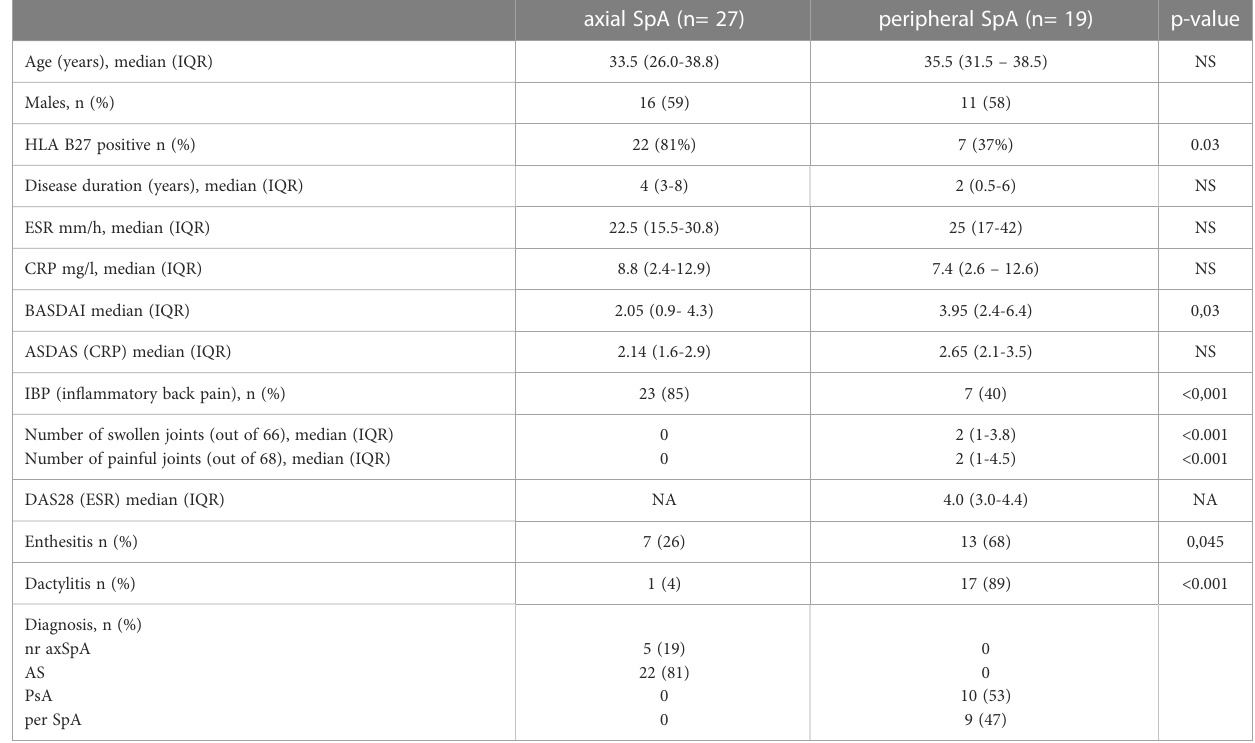
TABLE 1 Demographic and clinical characteristics of patient